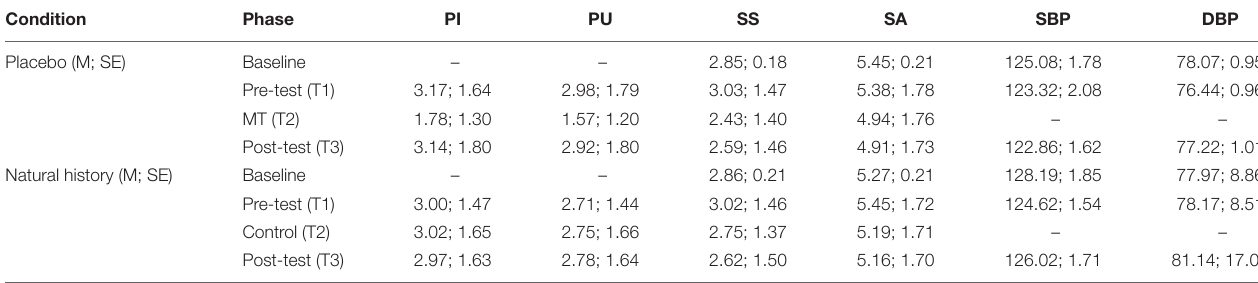
TABLE 1 | Pain intensity, unpleasantness, stress, arousal, systolic and diastolic blood pressure data across conditions and phases. Condition Phase PI PU SS SA SBP